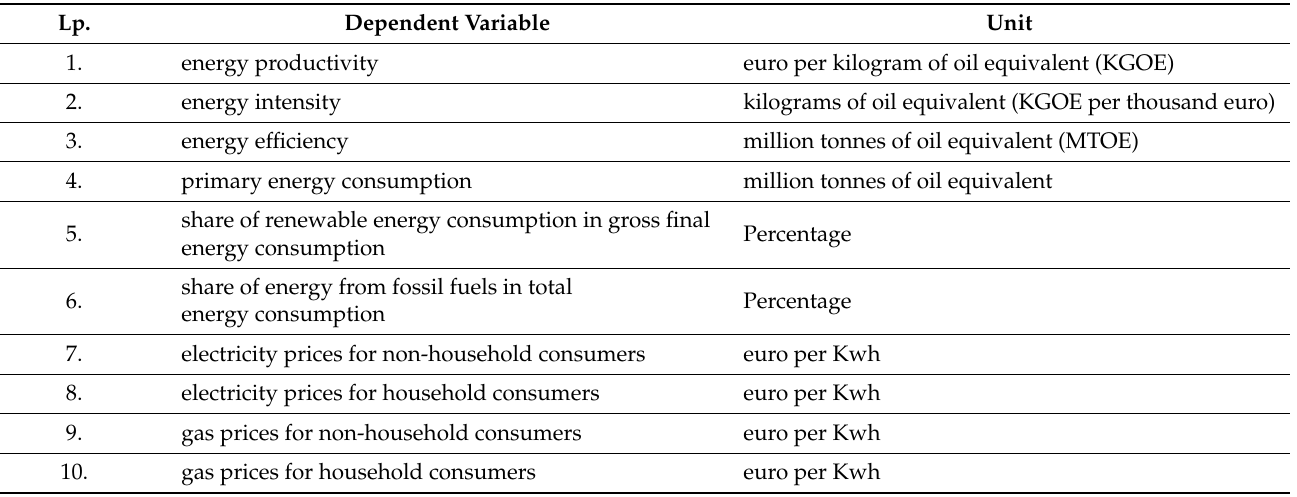
Table 1. List of dependent variables used to describe the degree of implementation of SDG No.